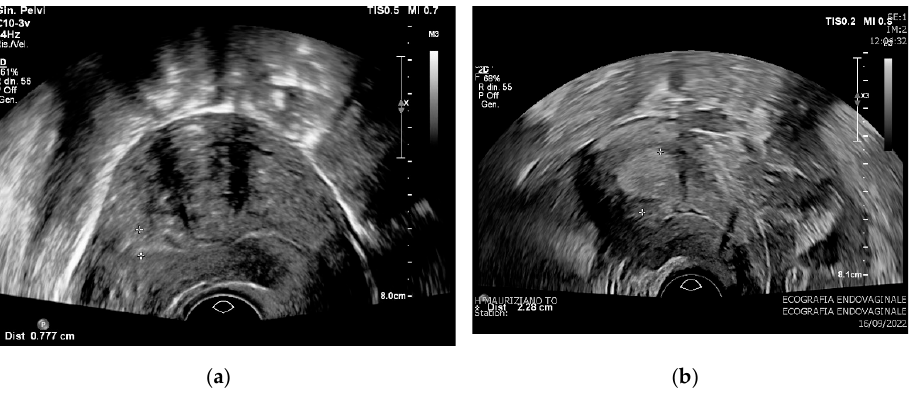
Figure 2. Transvaginal ultrasound (TVUS), endometrial thickness of two patients with a preoperative diagnosis of atypical endometrial hyperplasia (AEH). ( a ) TVUS: 7.7 mm of endometrial thickness with a posterior leiomyoma of the uterus, postoperative diagnosis of AEH. ( b ) TVUS: 22.8 mm of endometrial thickness, postoperative diagnosis of endometrial cancer pT1a G2.